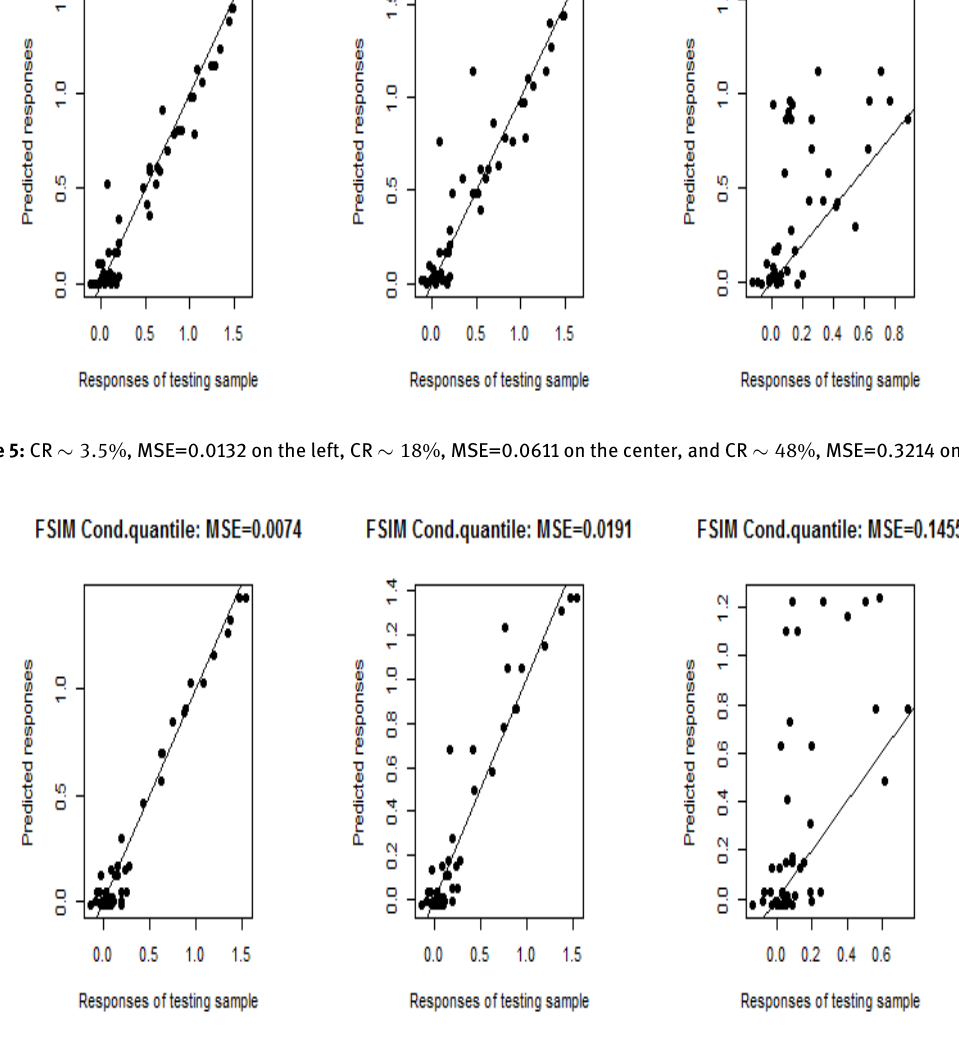
Figure 6: CR ∼ 3.5% , MSE=0.0074 on the left, CR ∼ 18% , MSE=0.0191 on the center, and CR ∼ 48% , MSE=0.1455 on the